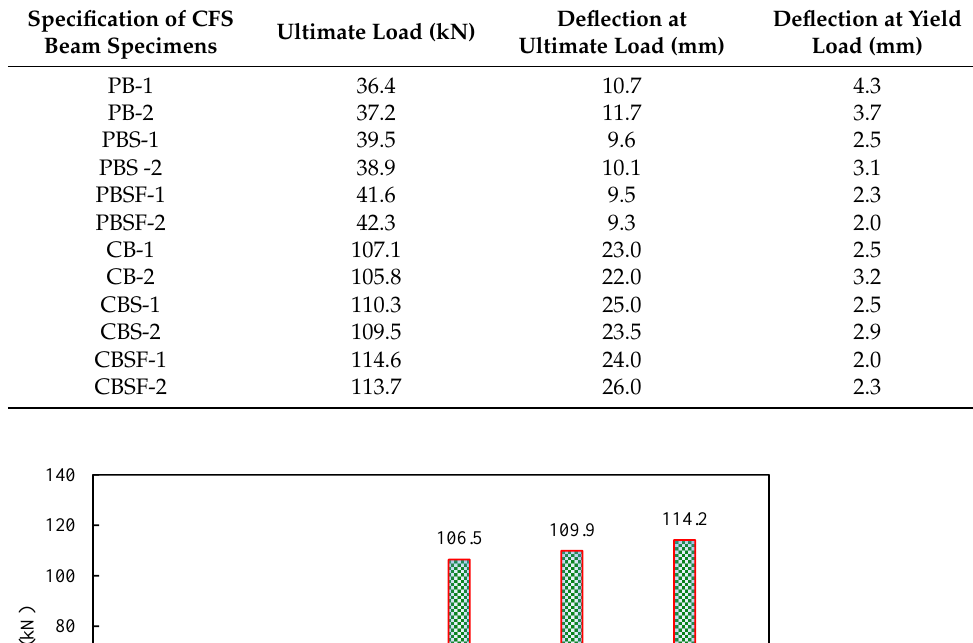
Table 2. Load–deflection results.